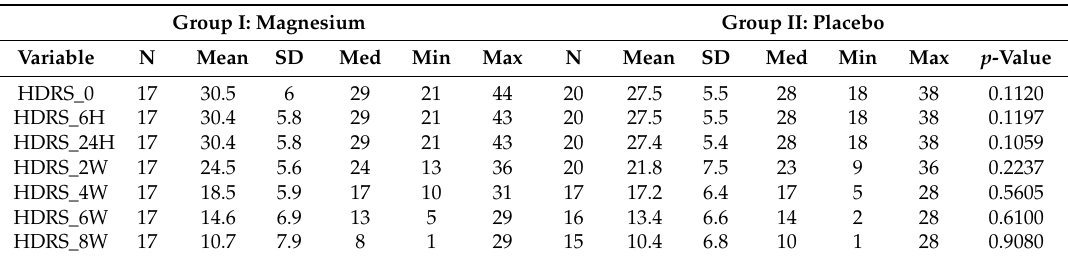
Table 1. Effect of magnesium or placebo supplementation on Hamilton Depression Rating Scale (HDRS) scores in patients treated with fluoxetine.